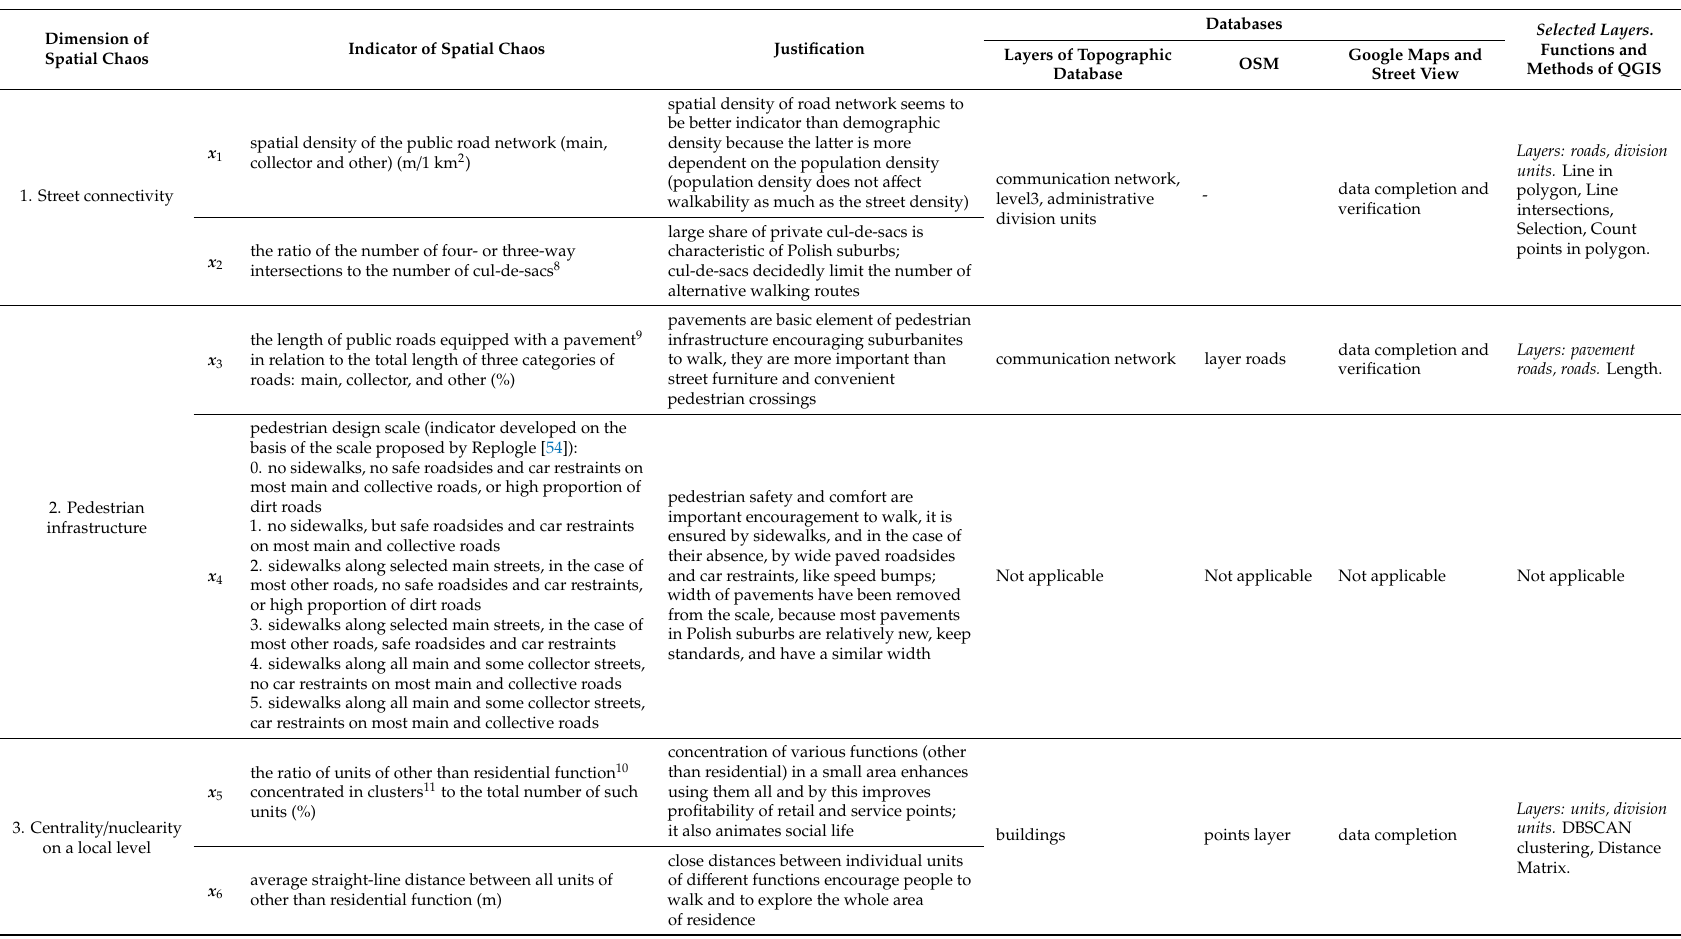
Table 1. Dimensions of suburban spatial chaos, databases and functions used for calculating particular